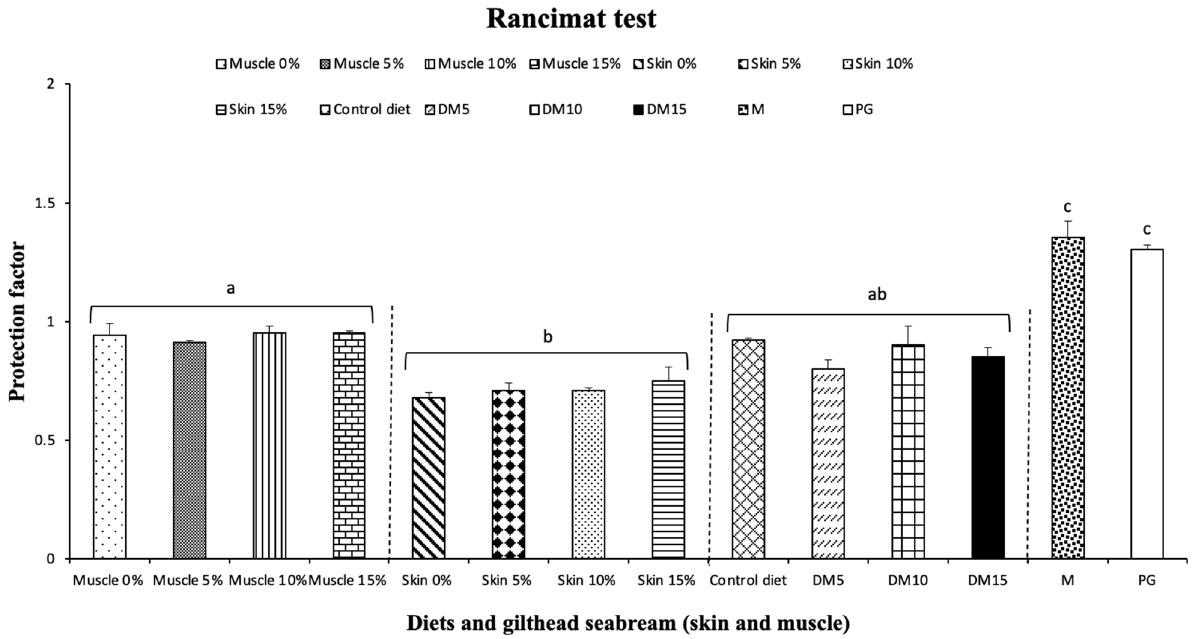
Figure 2. Antioxidant activity of diets with and without supplemented Moringa oleifera (MO) (5, 10 and 15%), MO leaves and samples of gilthead seabream (muscle and skin) fed with and without supplemented diet with MO for 4 weeks evaluated by Rancimat test, compared with activity of common food antioxidant additive, PG. All determinations were performed in triplicate and the columns represent the mean of PF ± standard deviation. Muscle 0%, muscle of Gilthead seabream fed control diet without MO; Muscle 5%, muscle of Gilthead seabream fed diet with 5% MO; Muscle 10%, muscle of Gilthead seabream fed diet with 10% MO; Muscle 15%, muscle of Gilthead seabream fed diet with 15% MO; Skin 0%, skin of Gilthead seabream fed control diet without MO; Skin 5%, skin of Gilthead seabream fed diet with 5% MO; Skin 10%, skin of Gilthead seabream fed diet with 10% MO; Skin 15%, skin of Gilthead seabream fed diet with 15% MO; PG, propyl gallate; Control diet, commercial diet; DM5, diet with 5% MO; DM10, diet with 10% MO; DM15, diet with 15% MO; M, MO leaves. Different superscript letters indicate significant differences (ANOVA, p < 0.05).